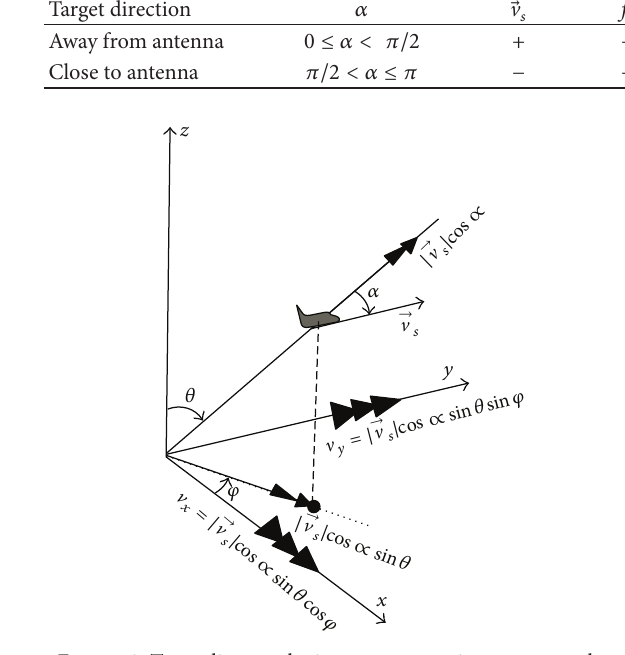
Figure 2: Target linear velocity components into antenna